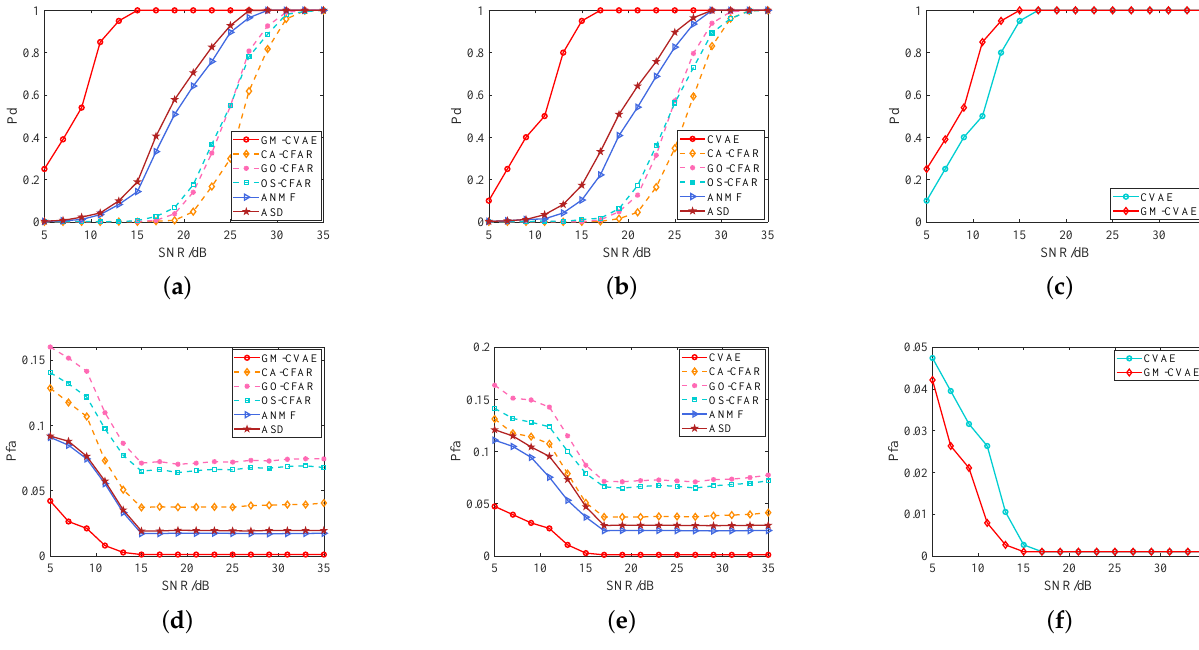
Figure 10. Complex-scene performance composed of clutter Type-1, Type-2 and Type-3: Comparison of detection probability ( a ) between GM-CVAE and CA-CFAR, GO-CFAR, OS-CFAR, ANMF and ASD methods; ( b ) between CVAE and the five traditional detection methods; ( c ) between GM-CVAE and CVAE; Comparison of actual false alarm rate ( d ) between GM-CVAE and the five traditional detection methods; ( e ) between CVAE and the five traditional detection methods; and ( f ) between GM-CVAE and